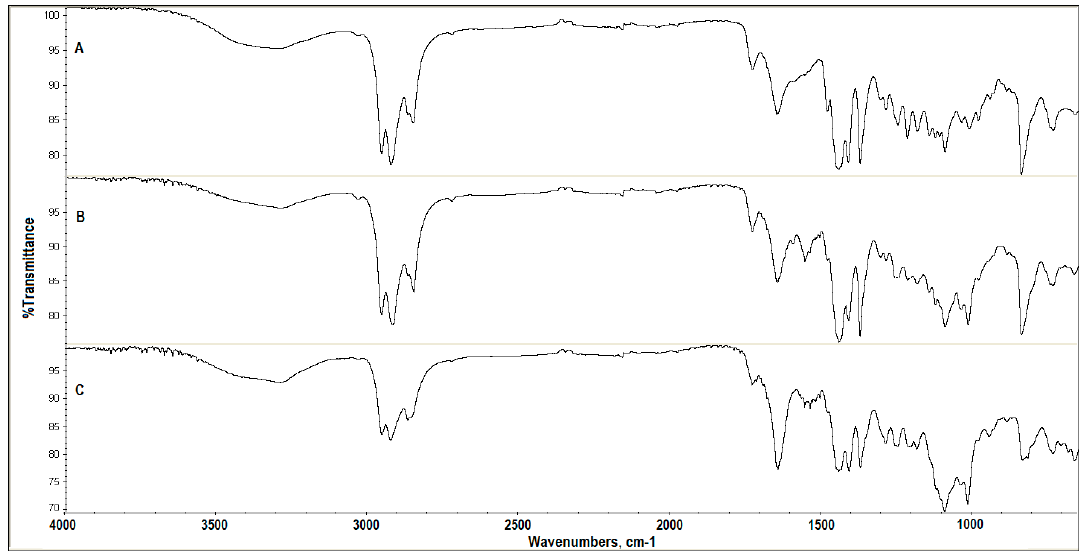
Figure 2 . FTIR spectra of the hydrogel catheter recorded during a two-stage modification using the SPA-M2 method: the untreated hydrogel catheter ( A ), the iodine-activated catheter ( B ), SPA-treated catheter ( C ).